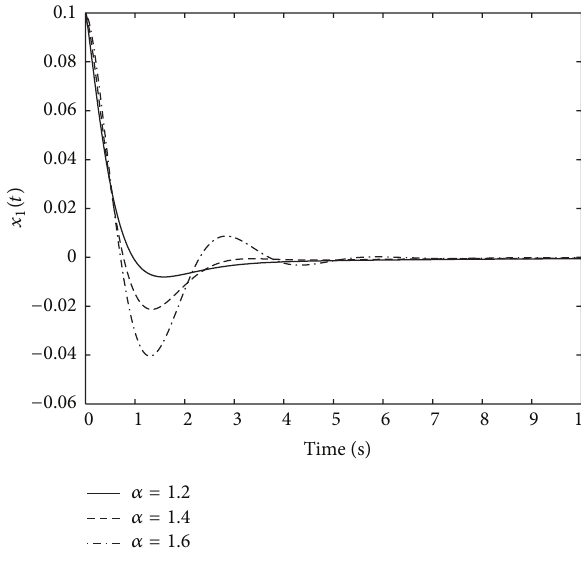
Figure 1: State response 𝑥 1 (𝑡) (0 < 𝛼 ≤ 1) . Figure 2: State response 𝑥 1 (𝑡) (1 ≤ 𝛼 < 2) .